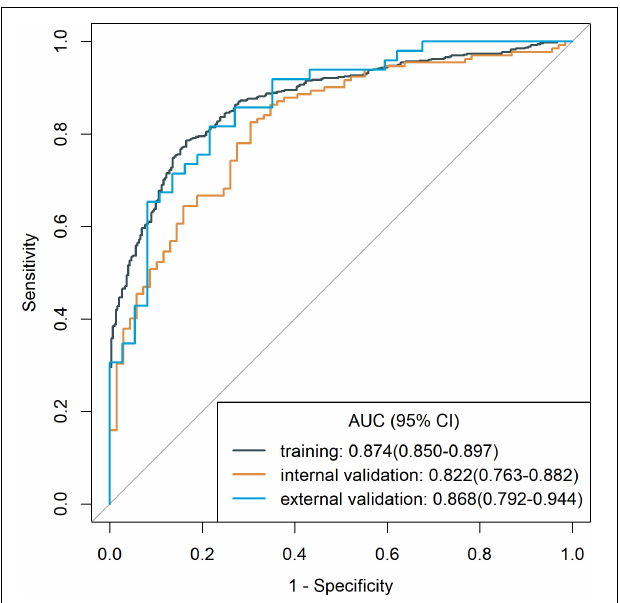
FIGURE 2 | Receiver operating characteristic curves of the model for assessing 90-day clinical functional outcome in the training cohort and validation